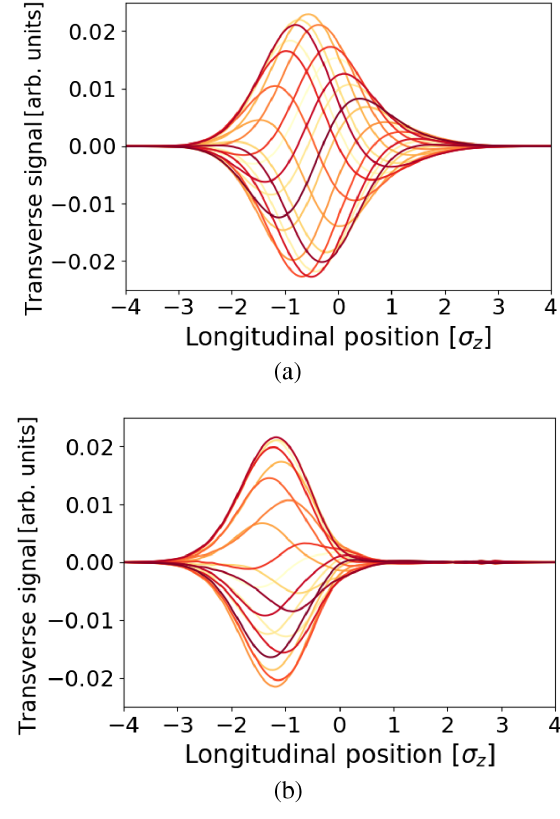
FIG. 9. Transverse signals obtained for the most unstable mode for different strengths of the space charge force and for a Gaussian distribution. The normalized intensity is 20. The positive longitudinal positions correspond to the head of the bunch, i.e., the part of the beam that arrives first at a given location around the ring. (a) Δ Q